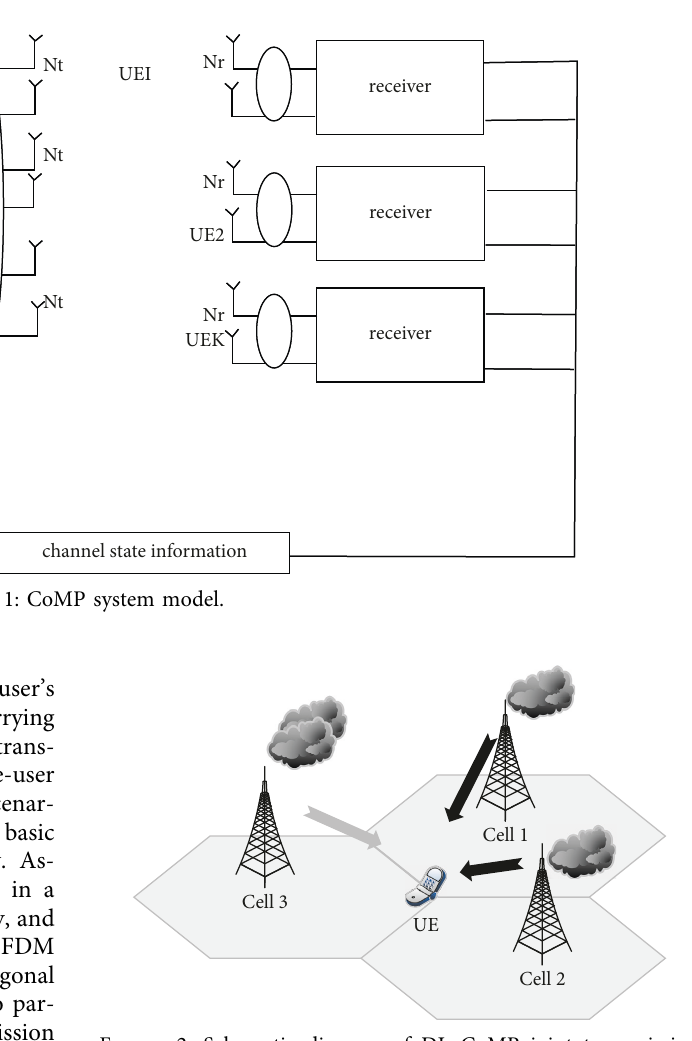
Figure 2: Schematic diagram of DL CoMP joint transmission technology